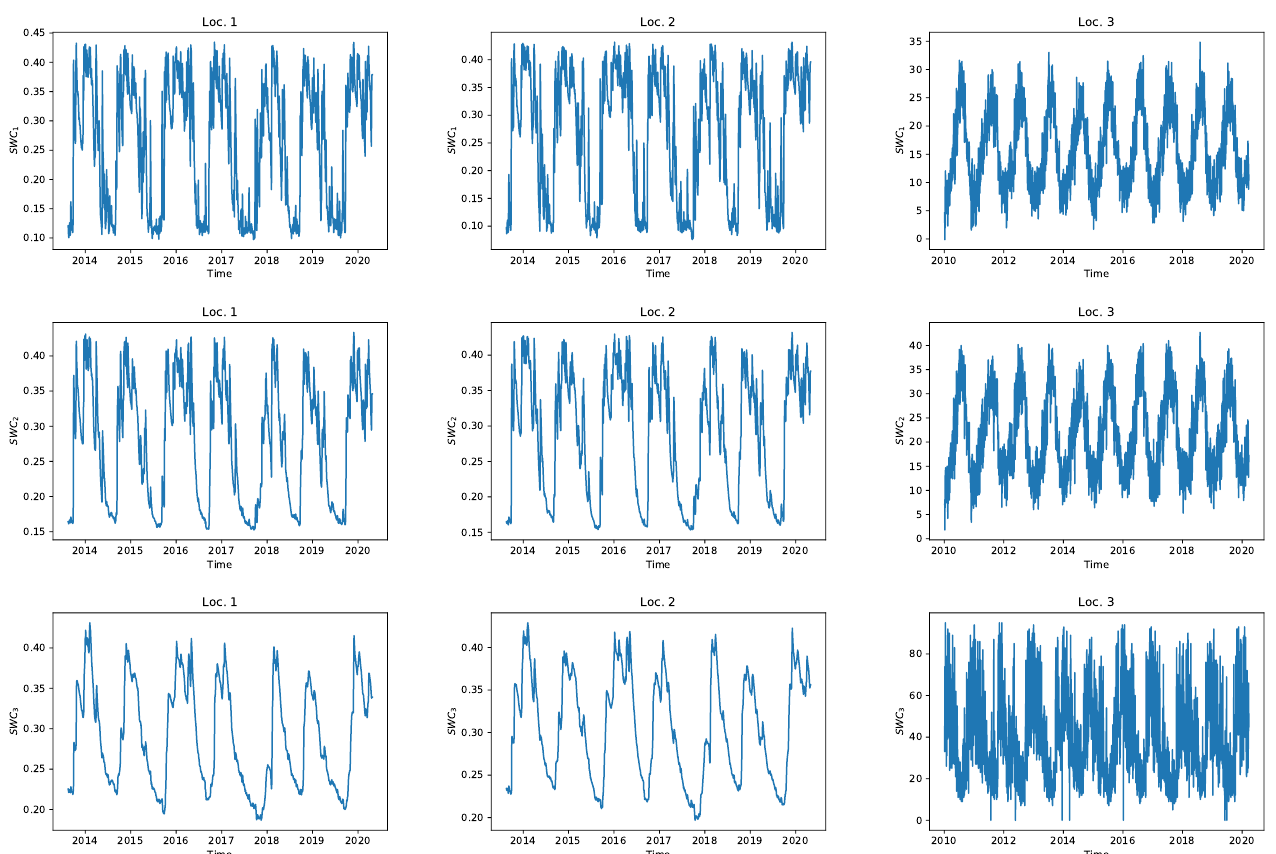
Figure 2. ETo and SWC at different levels for each